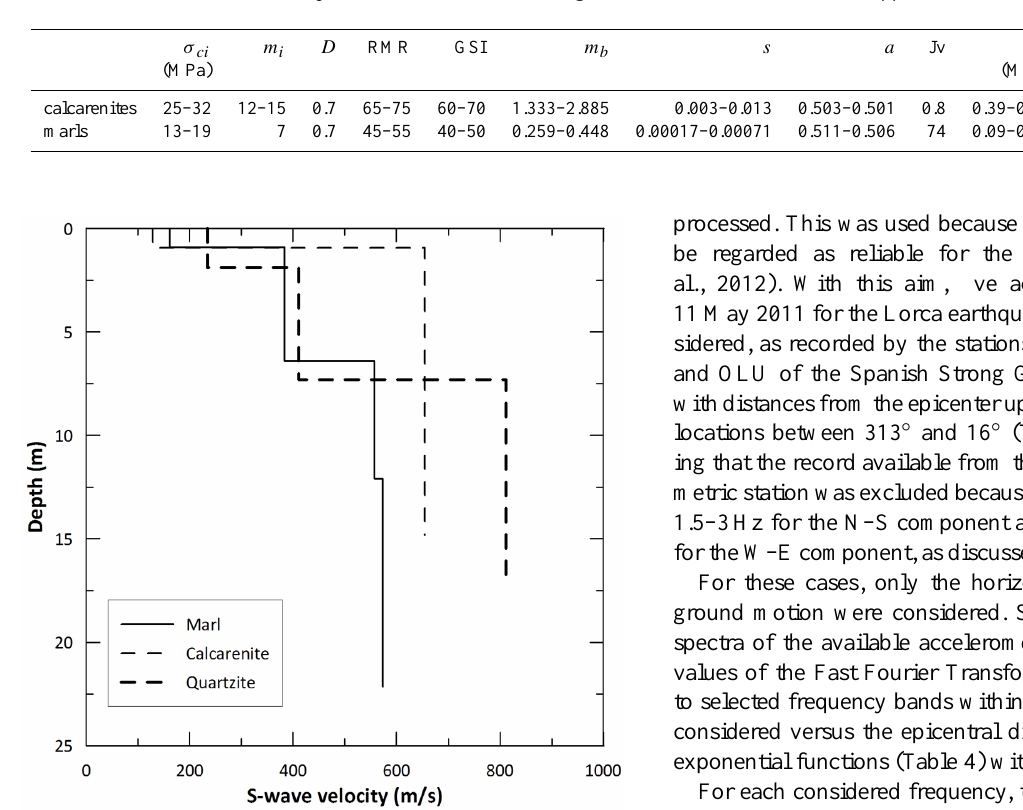
Table 2. Values assumed for the jointed rock masses according to the Hoek and Brown (2002) approach.